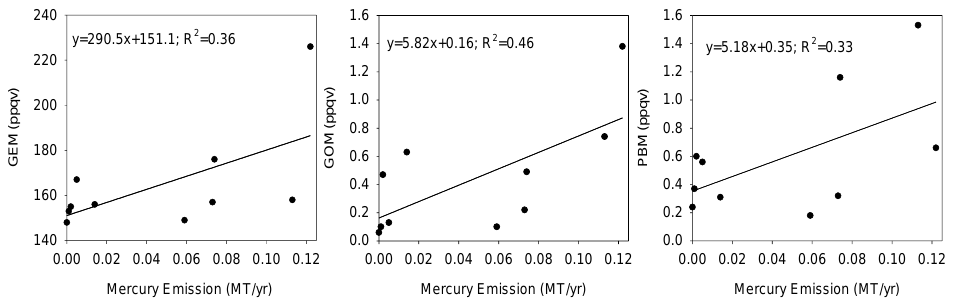
Fig. 5. Median values of GEM (left panel), GOM (middle panel) and PBM (right panel) versus the 2005 NEI anthropogenic mercury emissions within 50 km radius of the sampling sites. Refer to Table 1, 2, 3 and 4 for precise values.